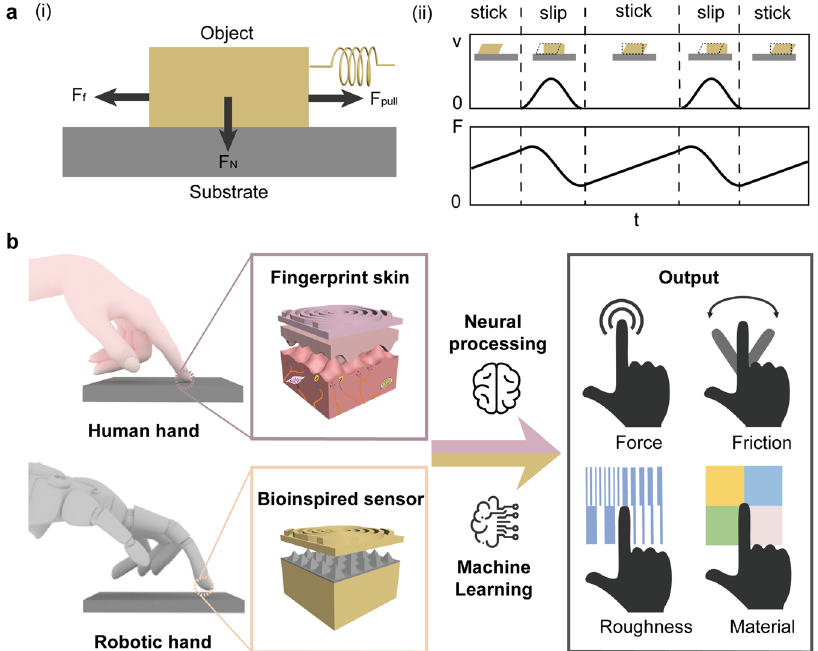
Fig. 1 Schematic illustrations of the stick-slip sensing strategy and the fi ngertip-inspired multifunction tactile sensor system. a (i) Simple frictional system contains an object that connected to a spring sitting on a frictional surface. The force F pull is set to keep the object moving given a normal force F N . F f is a force resisting the relative motion of object sliding against each other, which opposes the relative lateral motion of two solid surfaces in contact. (ii) The sliding friction force and speed as a function of time. According to the simple friction system, the force in the spring will increase with time until the force is suf fi cient to overcome the static frictional force. If the object then moves forward suddenly at a velocity greater than the velocity of the spring move, the force in the spring will decrease and the object will eventually stop. The object will remain stationary until the force in the spring once more builds up to a value suf fi cient to overcome the static frictional force. b Schematic illustration of the multifunction tactile system, containing the bionic design of tactile sensor, signals processing and output information, possessing the ability of force sensing, slippage detection, material classi fi cation and roughness